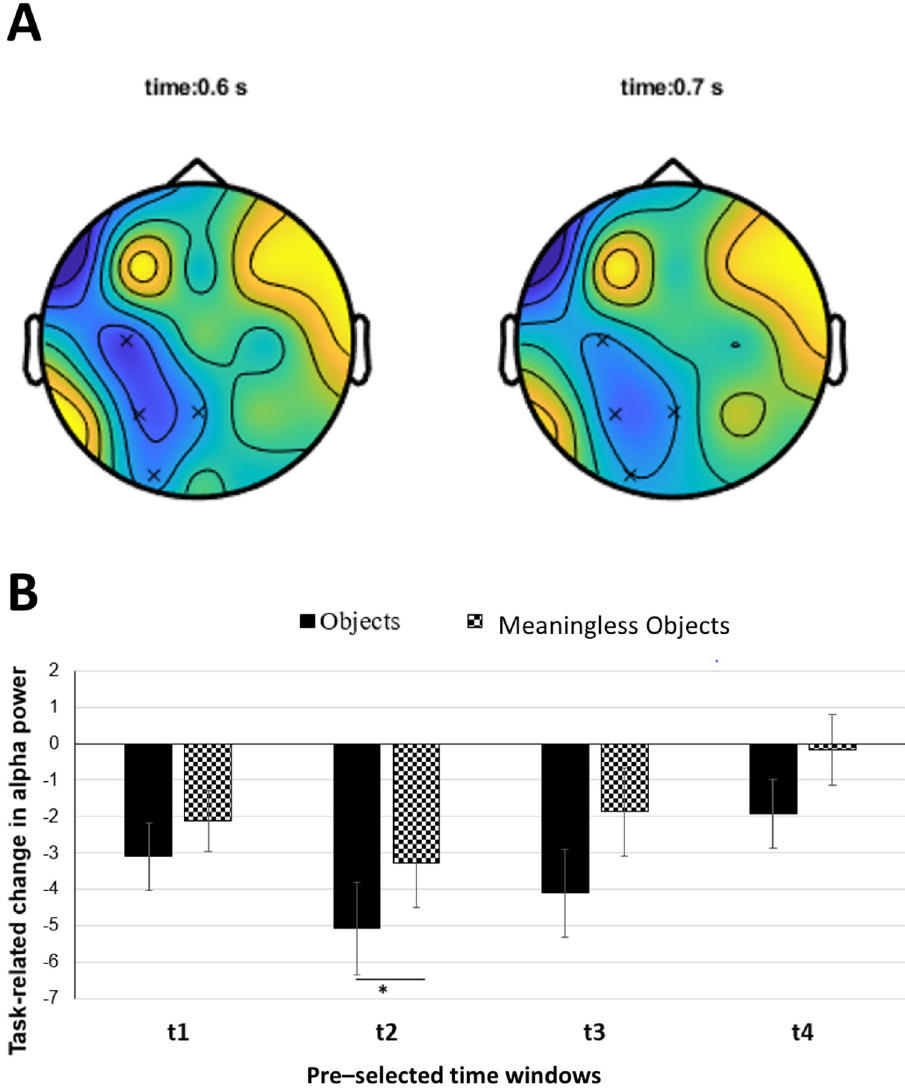
Fig 5. (A) Results of non-parametric cluster-based permutation analysis of power spectrum data for alpha band. Asterisks indicate electrodes that showed significant difference (p < 0.05) in alpha power between the two stimulus conditions (Objects minus meaningless objects) that occurred at 0.6s (left) and 0.7s (right). The prominent cluster visible over the left occipito-temporal region included C3, P3, Pz and O1 electrodes. (B) Task-related change in alpha power averaged for the significant electrode cluster (C3, P3, Pz and O1) and plotted for four time windows. Solid black bars represent object stimuli; checked bars represent meaningless object stimuli. t1 = 0–500 ms; t2 = 250–750 ms; t3 = C xy (f) = 500–1000 ms; t4 = 750–1250 ms. Error bars are SEM. Asterisks indicate p <